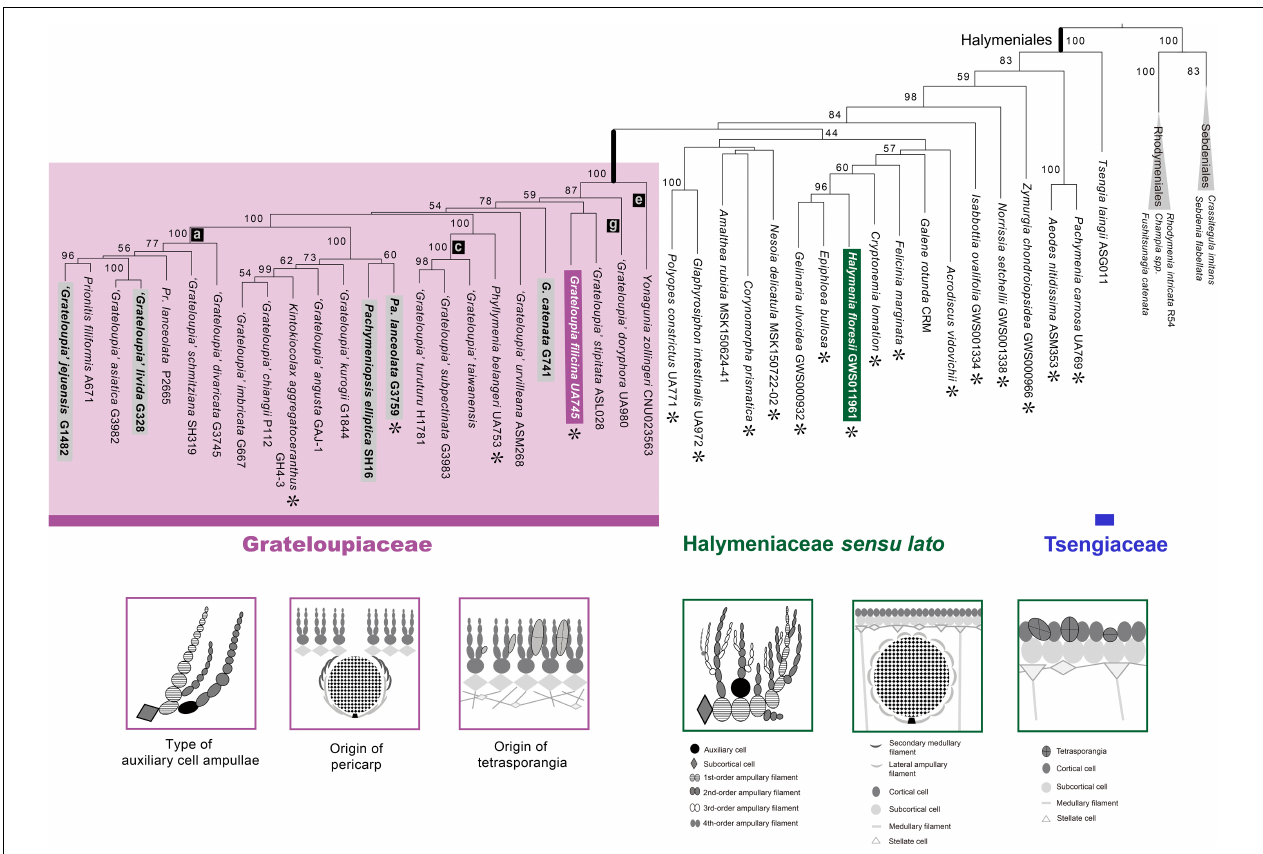
FIGURE 3 | ML phylogeny of the Halymeniales using a five-gene combined data set with three distinguishing morphological characteristics of the Grateloupiaceae compared to Halymenia floresii . The ML phylogeny was constructed using a five-gene concatenated data set of rbc L, psa A, psb A, cox 1, and LSU. Purple colored boxes indicate the characteristics of the Grateloupiaceae, and green colors show the characteristics of Halymenia floresii , the type species of the Halymeniaceae. Asterisks ( ∗ ) indicate the type species of each genus. Gray boxes indicate the taxa used for morphological